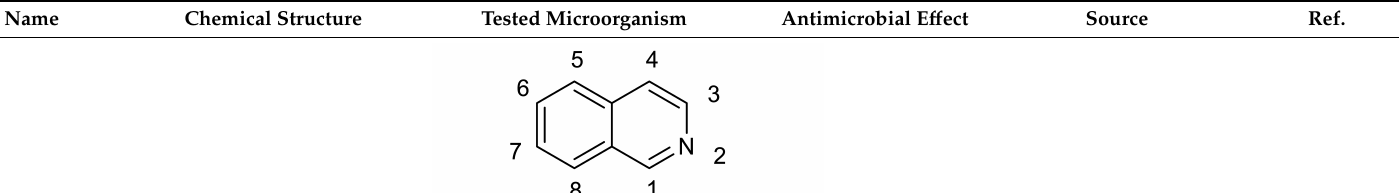
Table 4. Summary of antimicrobial activity of some classes of